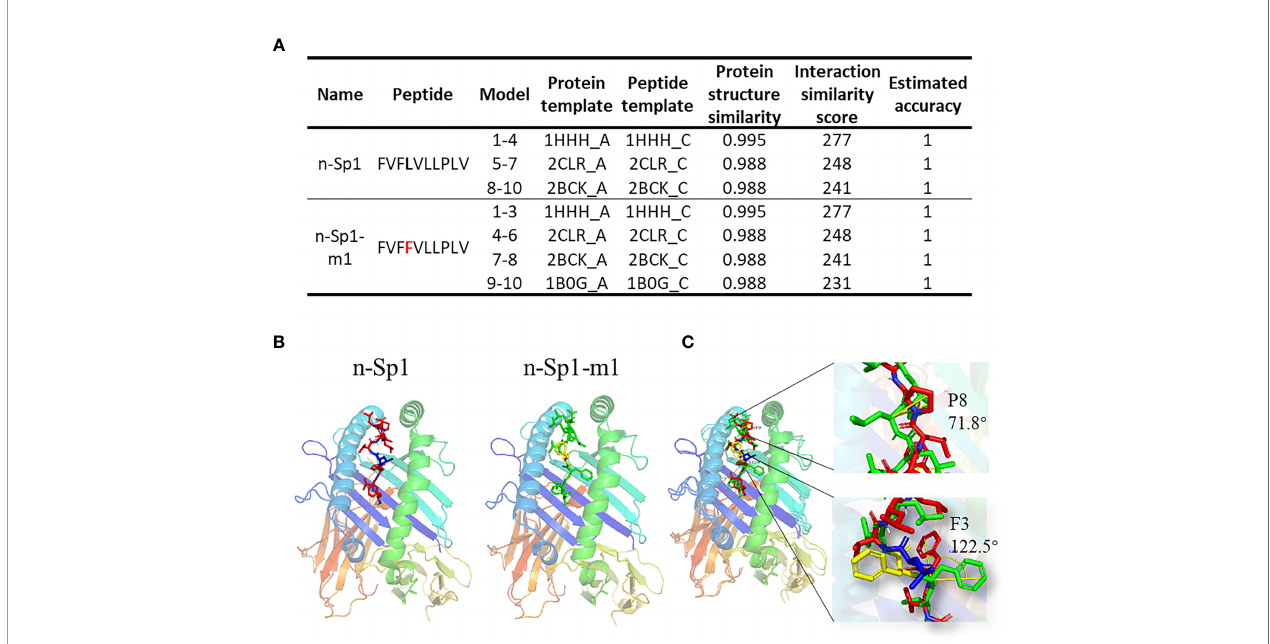
FIGURE 5 | Molecular mechanism of epitope mutant presentation on HLA-A2. (A) GalaxyPepDock was used for molecular docking to demonstrate the pMHC structure of n-Sp1 and n-Sp1-m1. Summaries of molecular docking, including the templates used for docking. The fi rst 4 characters of the template were PDB ID number. The models were ranked by the similarity scores and combined with the same parameters in one line. (B) Simulated crystal structure of pMHC were presented for n-Sp1 and n-Sp1-m1. The gray stick represented epitope peptide. (C) Comparison of pMHC structure between n-Sp1 and n-Sp1-m1. The HLA-A2 structure was shown as ribbon diagrams and n-Sp1 and n-Sp1-m1 mutation sites were shown as green and red sticks, respectively. The angle altered amino acids were indicated as F3 and P8 at position 4 and 8,